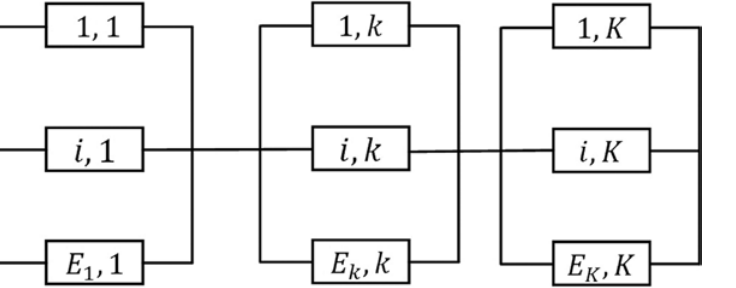
is the Number of Parallel Components K